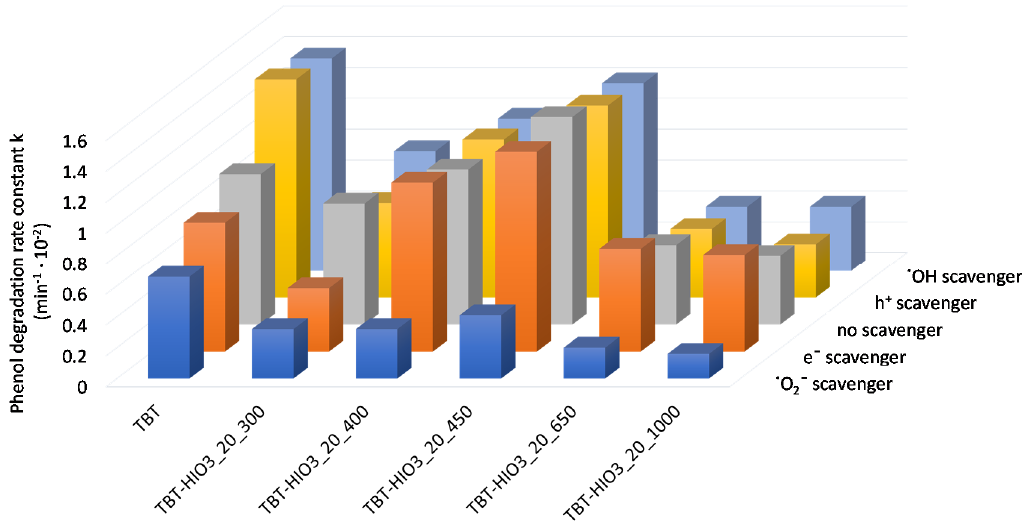
Figure 20. UV-Vis photocatalytic degradation of phenol for TiO 2 -HIO 3 _20_T photocatalysts in the presence of e − , h + , • O 2 − , and • OH scavengers.